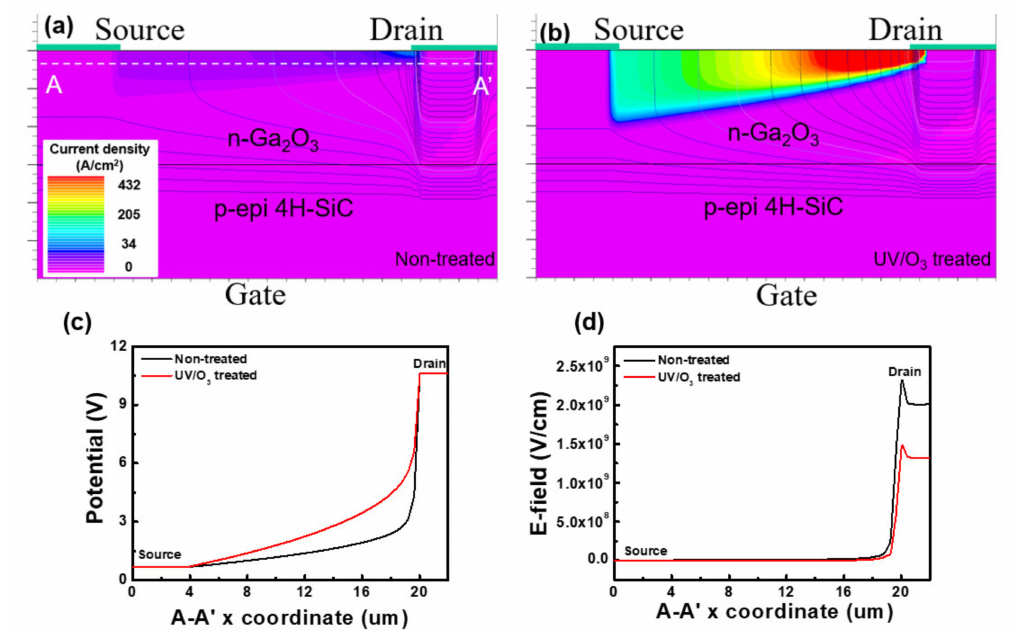
Figure 7. Simulated current density diagram of Ga 2 O 3 /4H-SiC SIT: ( a ) non-treated and ( b ) UV/O 3 -treated. The cutline profile along A-A (cid:48) : ( c ) potential and ( d ) electric field.